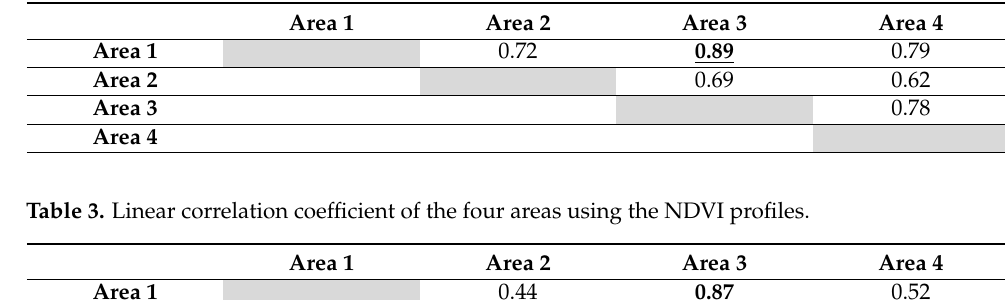
Table 2. Linear correlation coefficient of the four areas using the ARVI profiles.